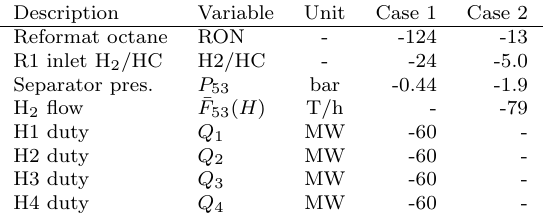
Table 9: Marginal values for active constraints with conditions from data set 12